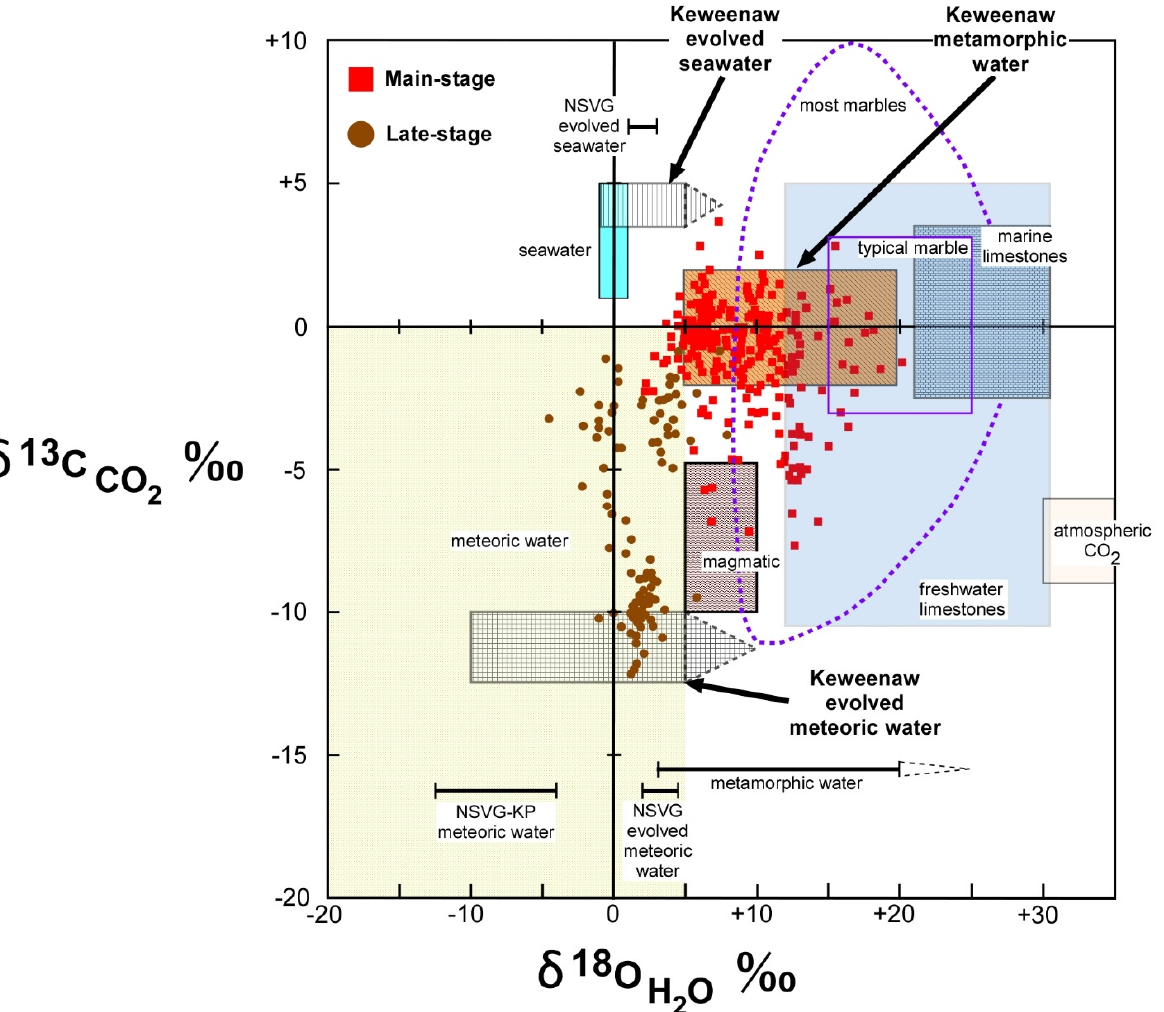
Figure 8. Interpretative carbon and oxygen isotopic co-variation of calcite from the Keweenaw Peninsula native copper district. Patterned boxes are proposed carbon and oxygen isotopic composition of Keweenaw metamorphic water, Keweenaw evolved seawater, and Keweenaw evolved meteoric water involved in the Keweenaw Peninsula native copper district. Only oxygen isotopic range for NSVG (North Shore Volcanic Group water involved in low grade metamorphic alteration from Park and Ripley [58], oxygen isotopic range for NSVG (North Shore Volcanic Group-Keweenaw Peninsula meteoric water from Park and Ripley and Livnat [6,58], and range of oxygen isotopic composition of metamorphic water from [51,57]; carbon arbitrarily plotted. Fields for carbon and oxygen isotopic composition of seawater, magmatic, typical marble (dotted outline), marine limestones, most marbles, freshwater limestones, and atmospheric CO 2 from Sharp [51]. Analytical and temperature uncertainty shown in Figure 5. Temperature uncertainty discussed in Sections 4.3 and 6.5.